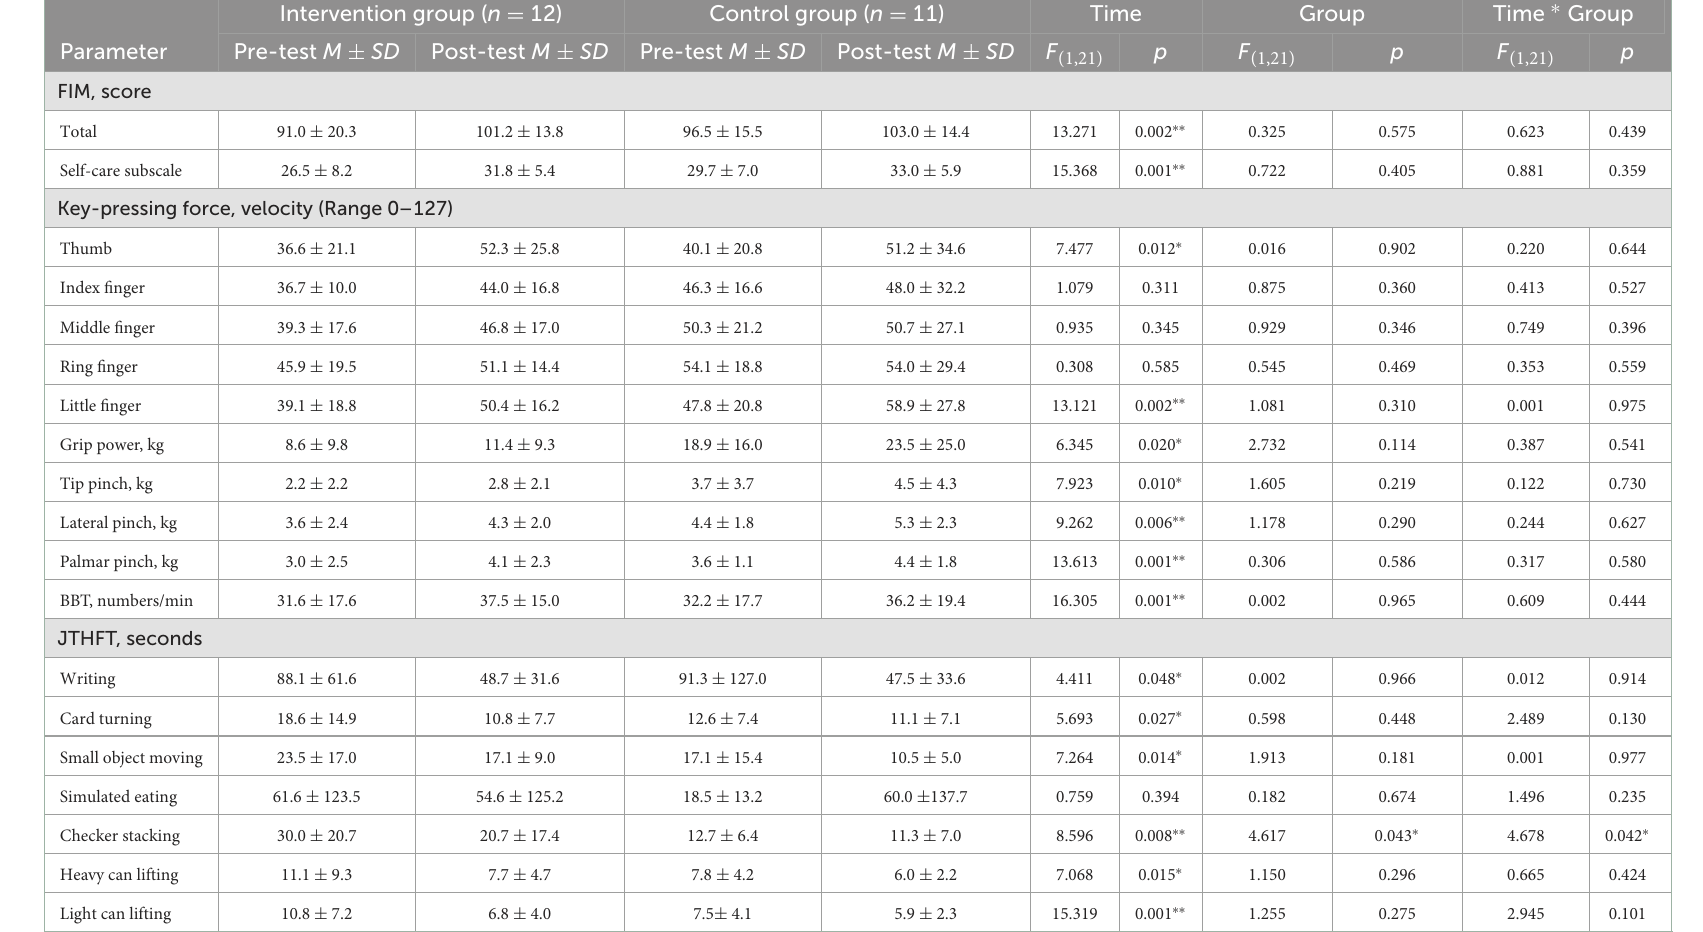
TABLE 3 Comparison of changes in hand function-related parameters between